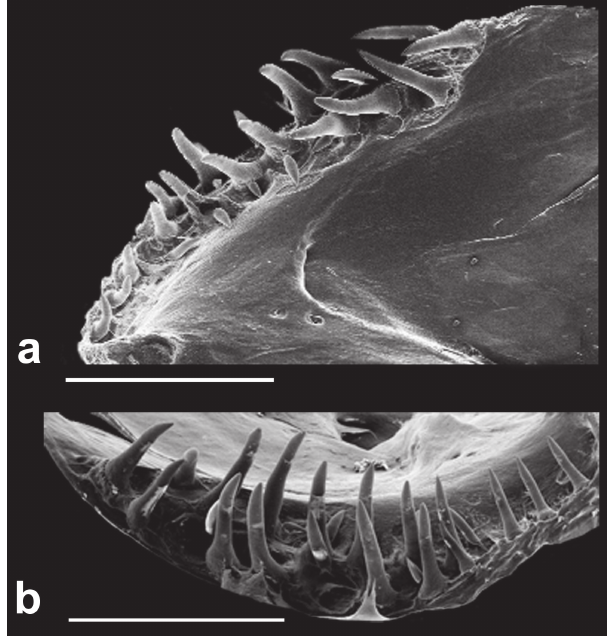
Fig. 4. Scanning electron micrographs. ( a ) lateral view and ( b ) dorsal view of right dentary of Eigenmannia sayona (MZUSP 119711, paratype, 116.2 mm LEA), showing the dentition pattern. Scale bar: 1 mm.